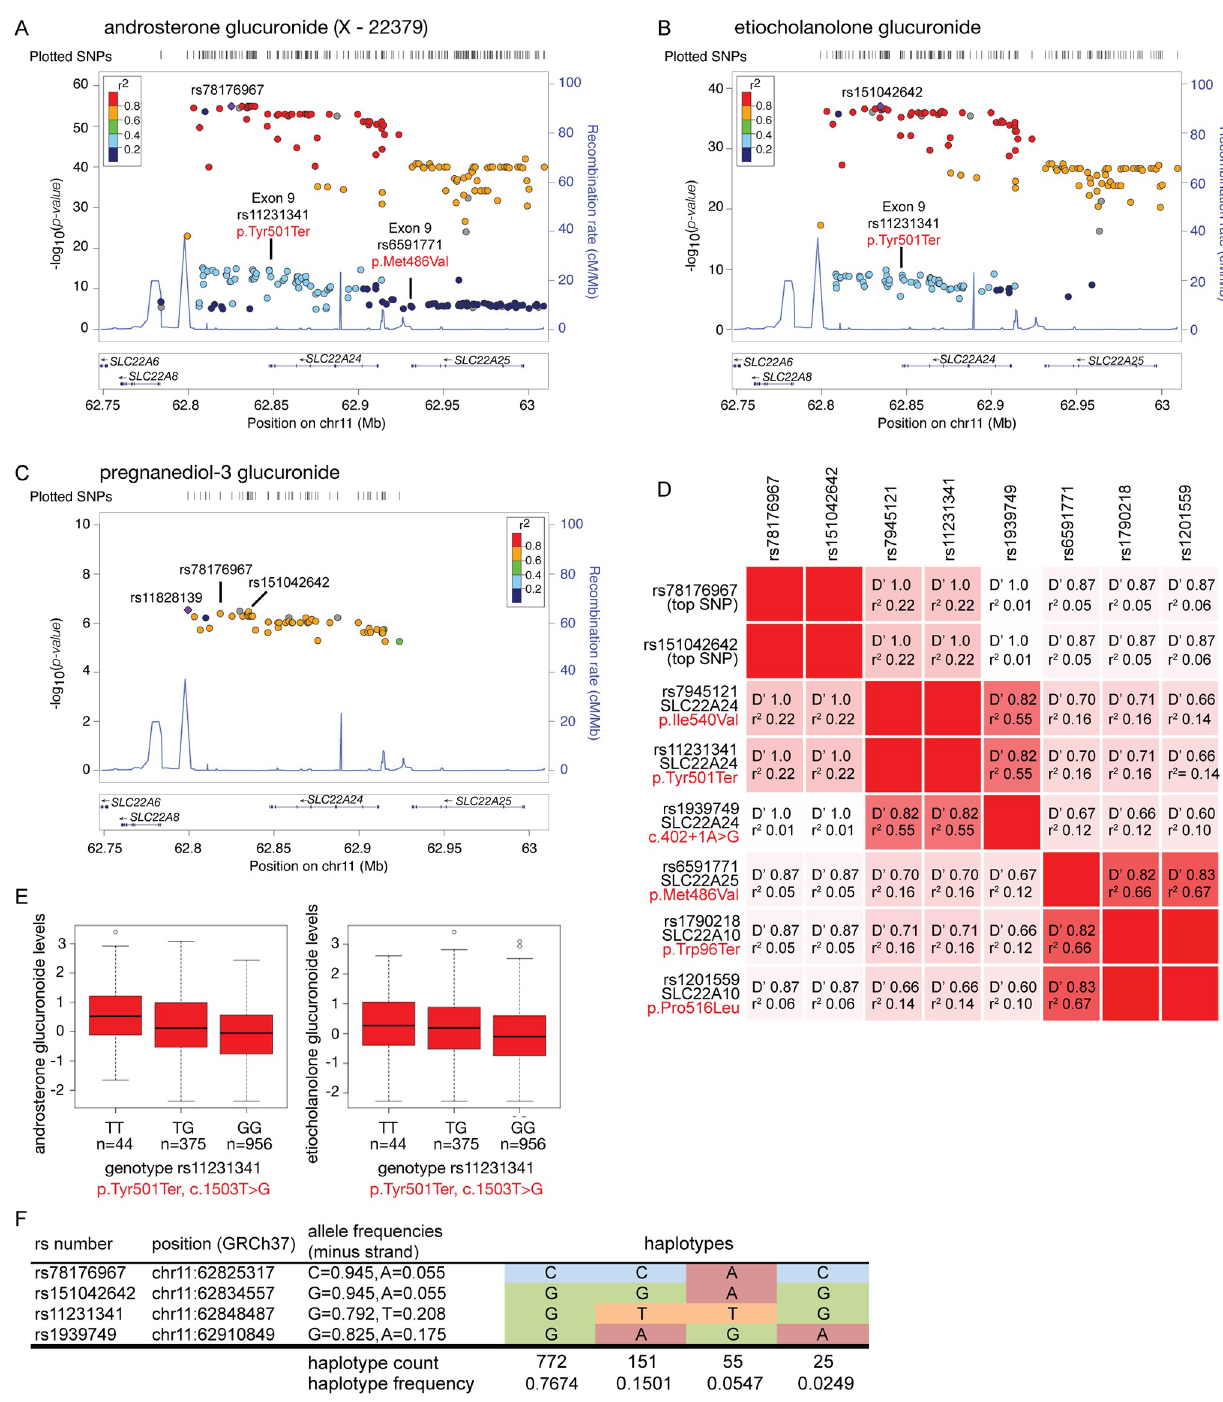
Fig 1. Genetic associations of variants in the SLC22A24 locus with steroid glucuronide levels. LocusZoom plot showing association results of top variants in the SLC22A24 locus with (A) androsterone glucuronide (X-22379), (B) etiocholanolone glucuronide and (C) pregnanediol-3 glucuronide. The LD estimates are color coded as a heatmap from dark blue (0 < r 2 < 0.2) to red (0.8 < r 2 < 1.0). Recombination rate are indicated by the solid blue lines (recombination rate in cM/Mb from HapMap). The bottom panel shows the genes and their orientation. The associations were plotted using available data from Long T. et al. (http://www.hli-opendata.com/Metabolome/, S1 Table). Underlying data are also provided in S1 Data. (D) The linkage disequilibrium as calculated by D prime (D’) and correlations (r 2 ) between the top SNPs rs781769767 and rs151042642 with missense and nonsense variants in SLC22A24 , SLC22A25 and SLC22A10 . (E) Genetic association of SLC22A24 p.Tyr501Ter with normalized residuals of androsterone glucuronide and etiocholanolone glucuronide in the ARIC study (N = 1375 Caucasians). The major allele of rs11231341 coding for p.Tyr501Ter is significantly associated